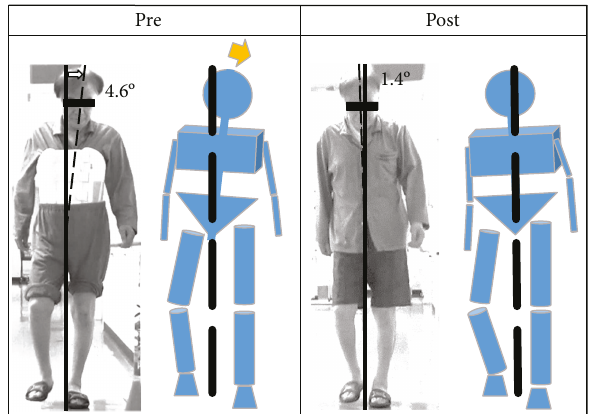
Figure 4: Representative case showing improvements in walking appearance. Prior to Hybrid Assistive Limb (HAL) treatment, the trunk leaned toward the left when standing with the left leg. Furthermore, the trunk was leaned 4.6 ° to the left. After 12 sessions of HAL treatment, the upper body was stabilized. Pre: before training; Post: after